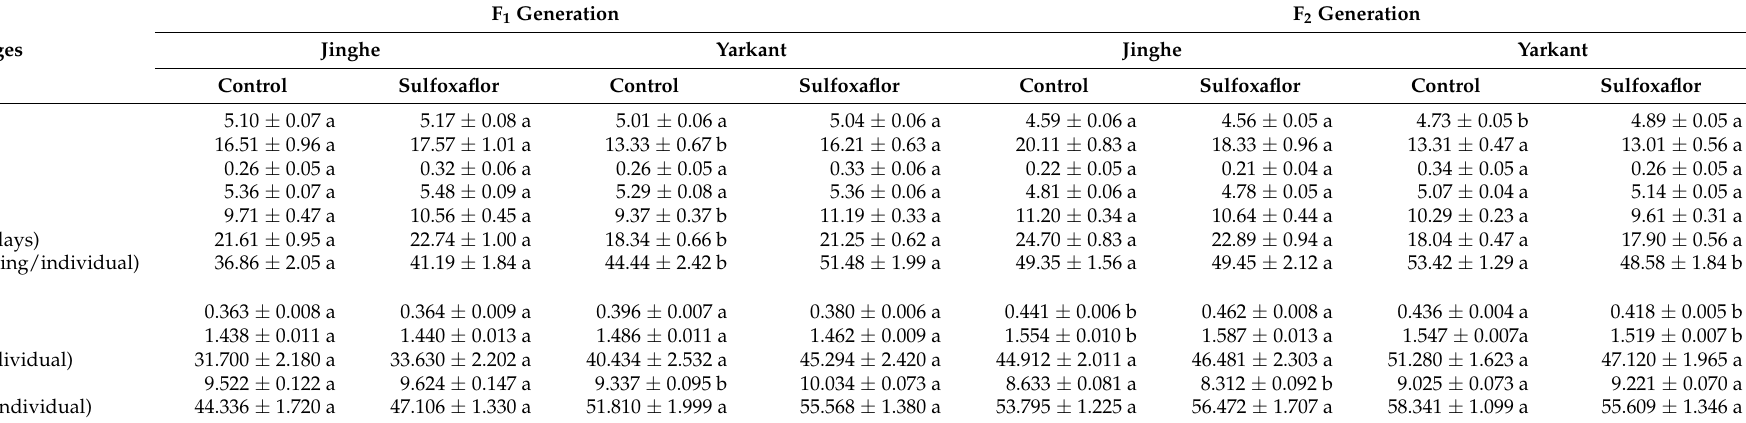
Table 3. Sublethal effects of sulfoxaflor on the duration of development and the population parameters of F 1 and F 2 generation in Yarkant and